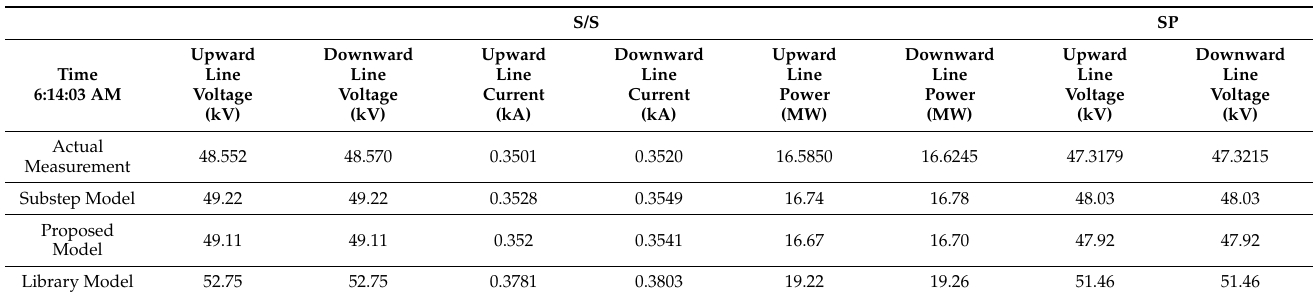
Table 7. Case study result (comparison of actual measurement data with the RTDS simulation results obtained using each model (the Substep model, the proposed model, and the Library model)). S/S SP